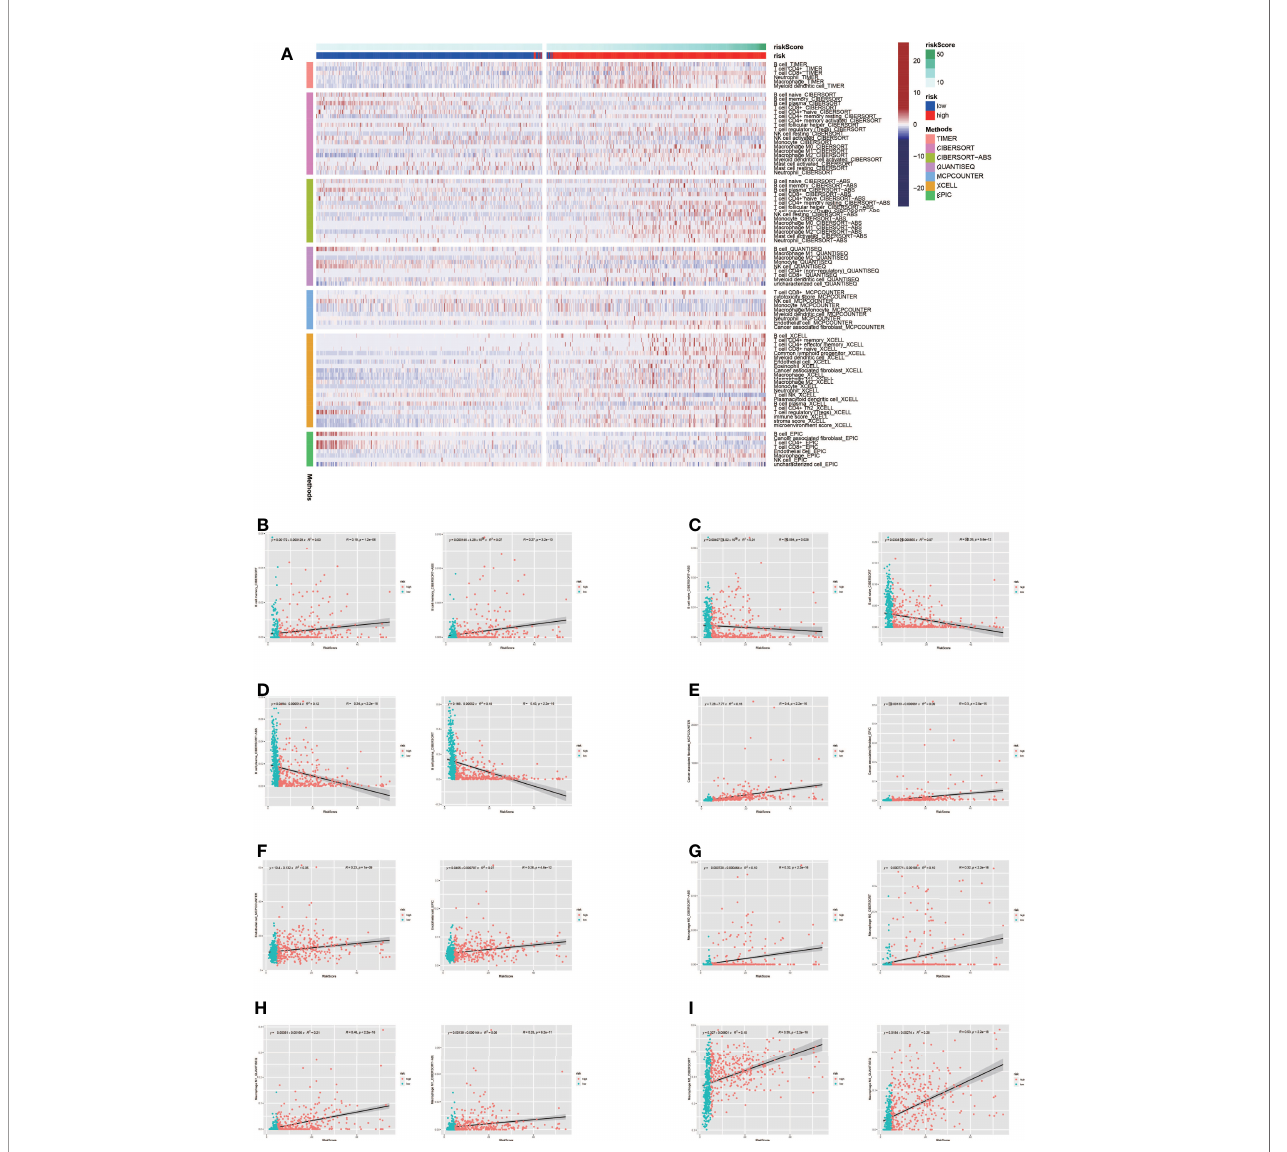
FIGURE 5 | Analysis of immune microenvironment. (A) Immune landscape in high-risk and low-risk groups. The high-risk group tended to have higher levels of immune cell in fi ltration. (B-I) Many immune cells were signi fi cantly correlated with risk